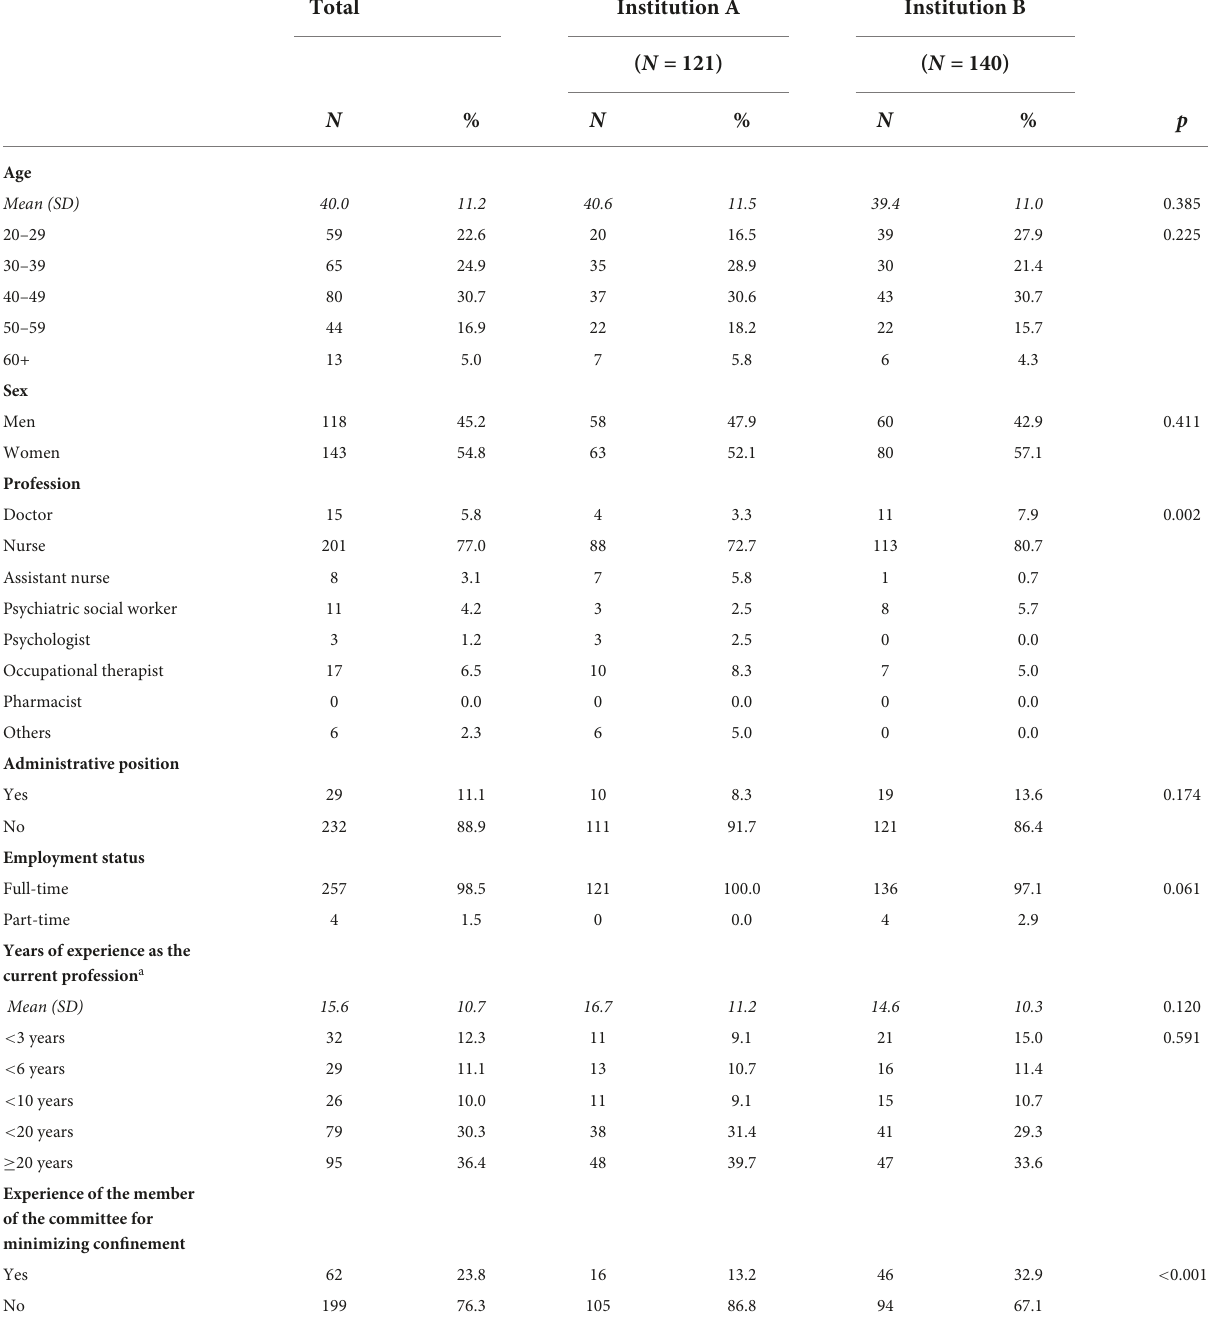
TABLE 1 Demographic and work-related characteristics of the respondents ( N =